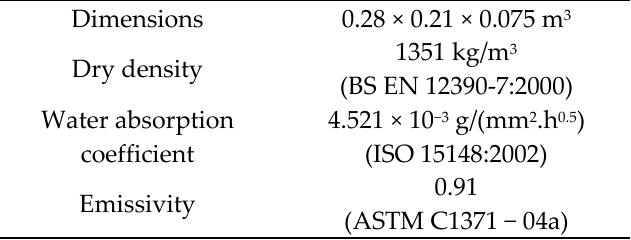
Table 1. Main characteristics of the lightweight concrete under study (measured).